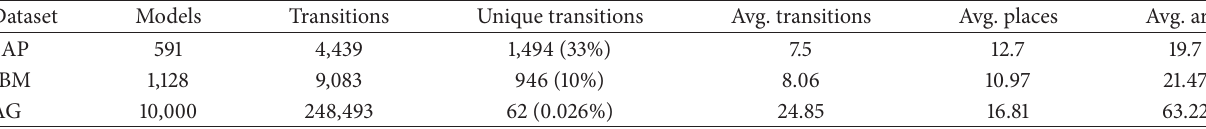
Table 2: Structural characteristics of the three